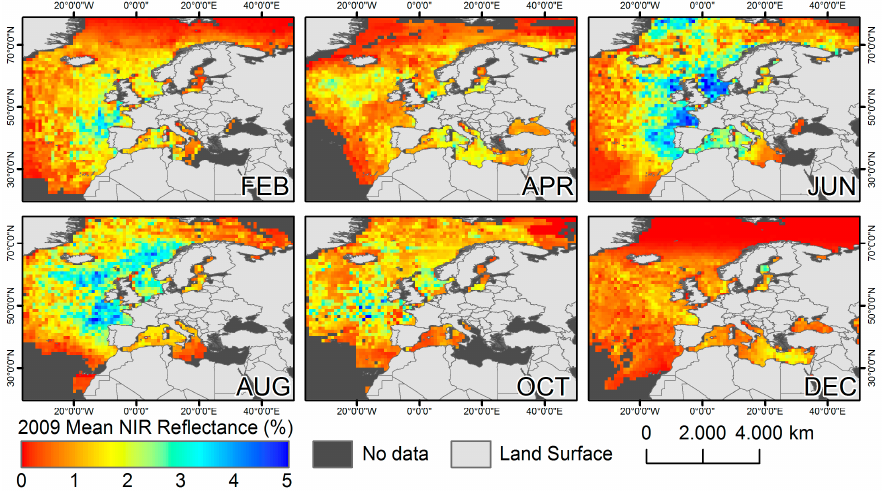
Figure 3. Mean reflection per 1 × 1 degree pixels for selected months in 2009.